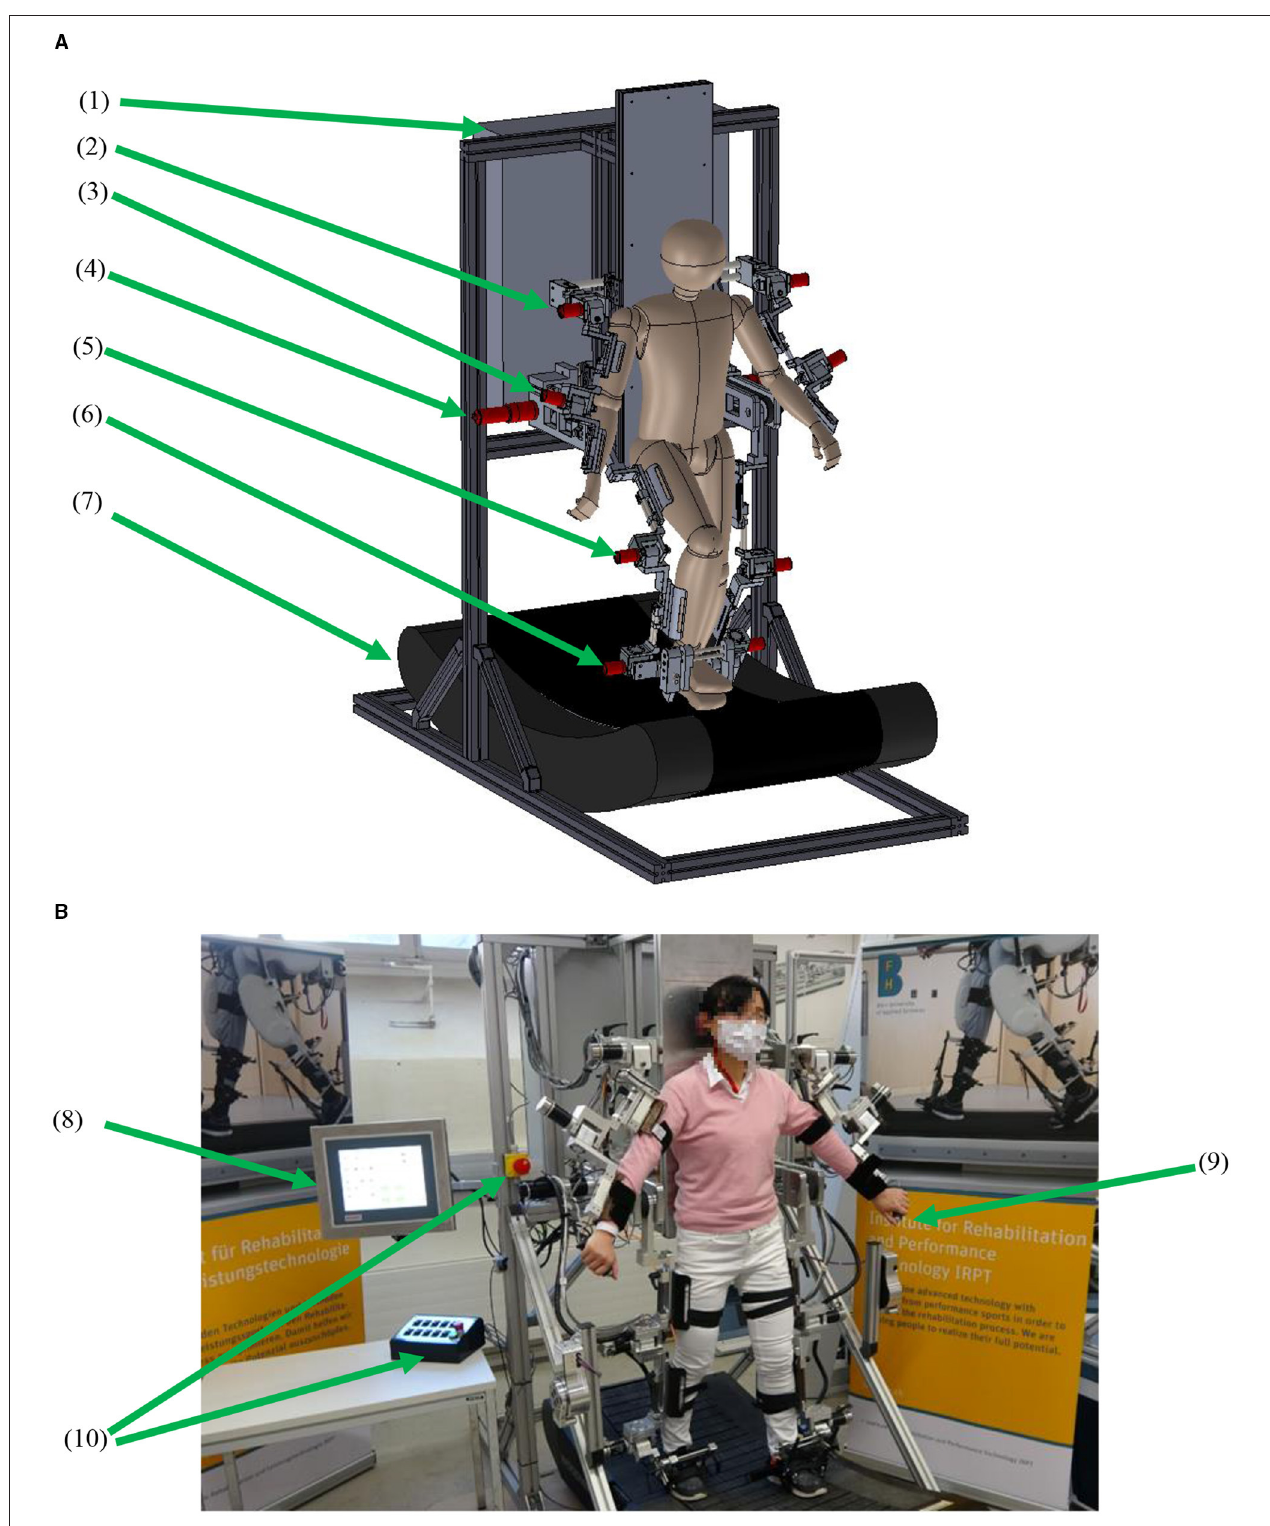
FIGURE 1 | The arm-leg robotic system. (A) CAD model and (B) prototype. (1) Control unit, (2) shoulder actuator, (3) elbow actuator, (4) hip actuator, (5) knee actuator, (6) ankle actuator, (7) curved treadmill, (8) touch panel, (9) hand-held stop, and (10) stops for operators.